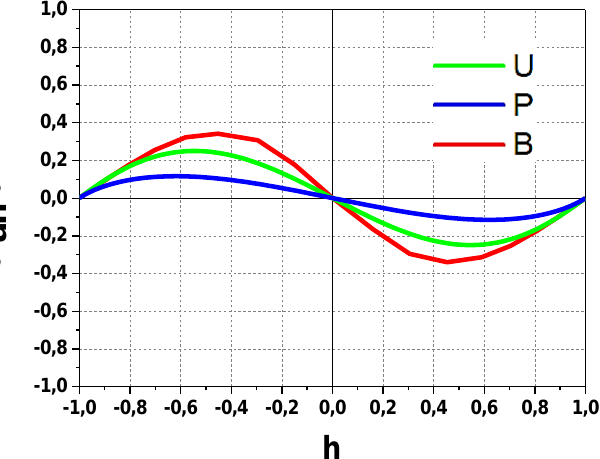
Figure 9. Deviations induced by the beam profile in measurements of plasma potential as a function of the secondary beam centerline position h for uniform (U), parabolic (P) and bell-shape (B) beam profile. The plasma potential Φ pl in measurements with 90 ◦ CEA is obtained from relation